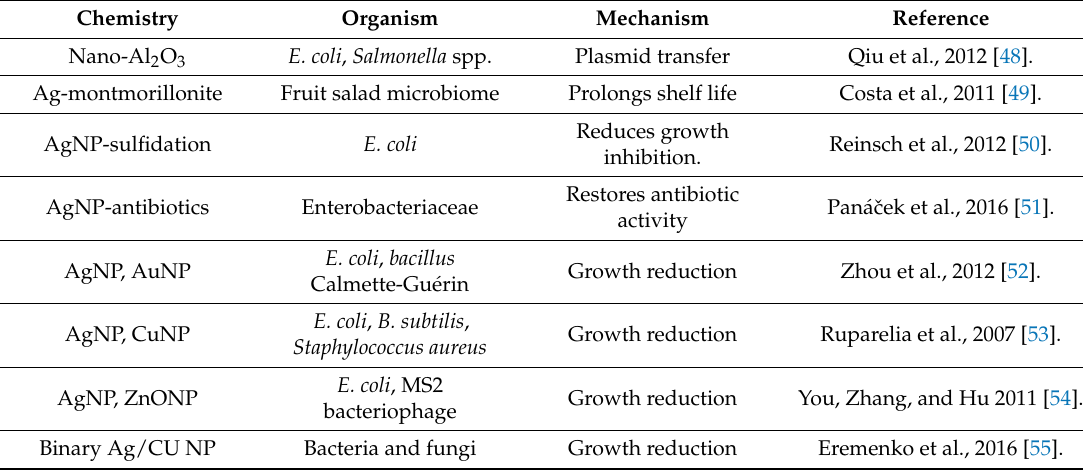
Table 1. Summary of select studies of the antimicrobial effects of